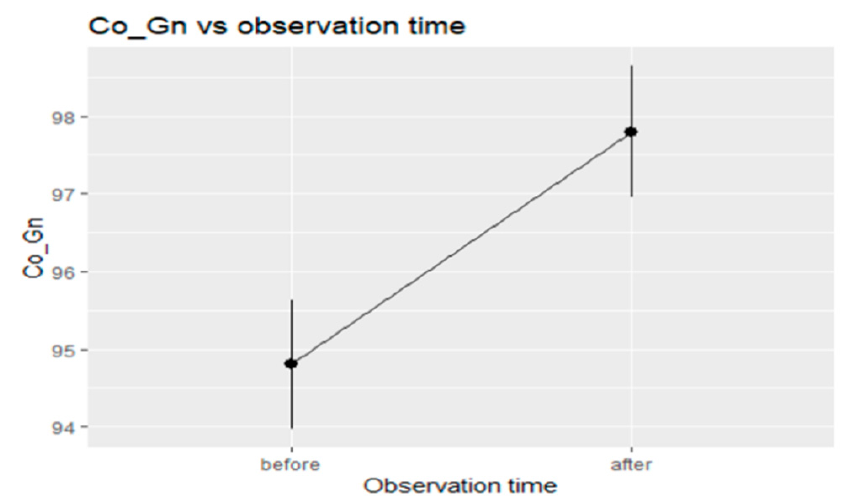
Figure 12. Trend in Co-Gn over time from T0 to T1.